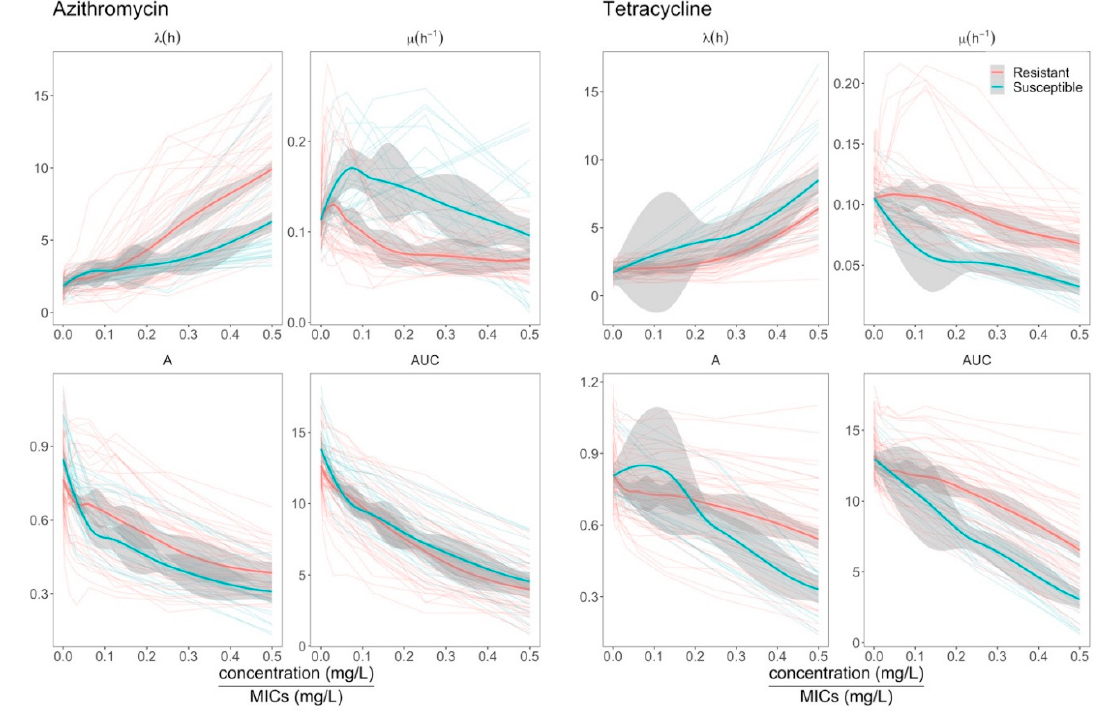
Figure 4. A comparison between growth features of resistant and susceptible isolates under exposure to azithromycin and tetracycline. The horizontal axis is antimicrobial concentrations relative to MICs. The vertical axis is values of the four growth features, including lag time ( λ ), maximum growth rate ( µ ), maximum cell density (A), and area under the curve (AUC). For each isolate, growth features were plotted against relative concentrations of antimicrobials as thin lines. Bold red (resistant isolates) and blue (susceptible isolates) lines indicate loess smooth regression. Gray shading represents 95% confident intervals.